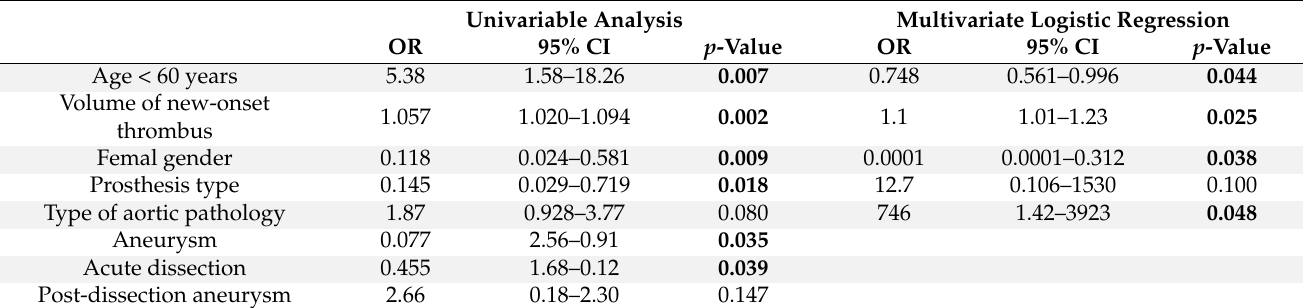
Table 4. Multivariate analysis of the significant variables associated with the occurrence of IR. Univariable